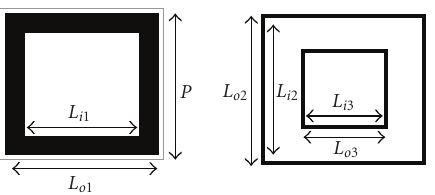
Figure 1: FSS1 and FSS2 unit cells geometry.